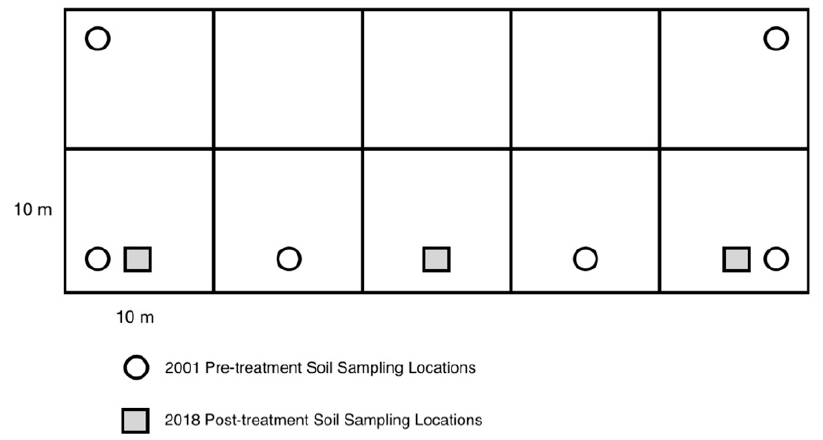
Figure 2. Pre-treatment (2001) and post-treatment (2018) sampling locations for forest floor and mineral soil collection at the Green River Game Lands, Asheville, NC, USA.